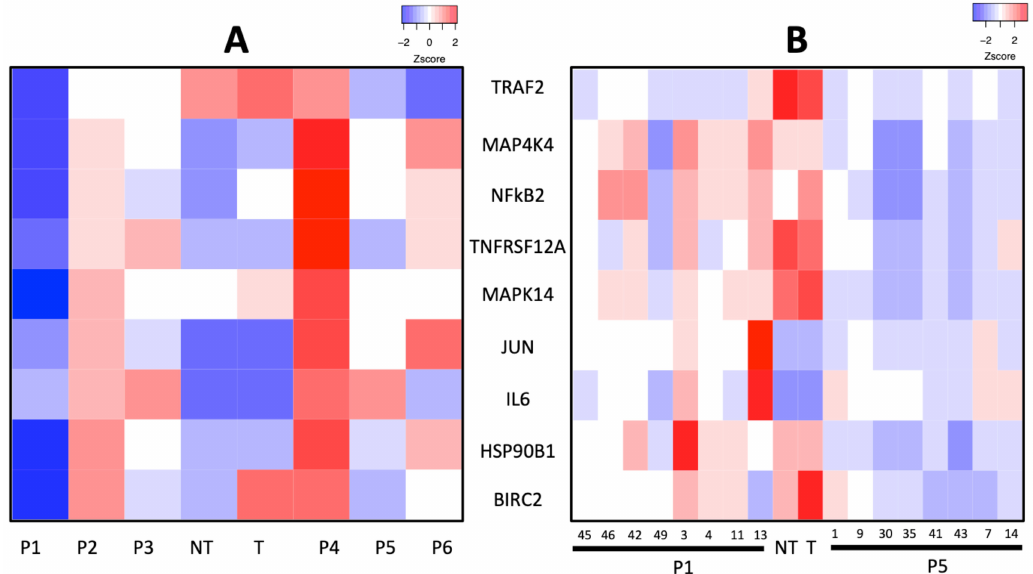
Figure 4. Gene expression of selected genes in TWEAK-Fn14 signalling pathway in response to peptide treatment. ( A ) Heatmap representing the normalized expression of genes (Y axis) in response to the treatment with pooled pep- tides (Pool 1 to 6; P1, P2, P3, P4, P5 and P6) as well as the response of BRV5 cells not treated (NT) and treated with TWEAK (T) (X axis). ( B ) Heatmap representing the normalized expression of genes (Y axis) in response to the treatment with individual peptides (P1 pool: P45, P48, P42, P49, P3, P4, P11, P13; P5 pool: P1, P9, P30, P35, P41, P43, P7, P14) as well as the response of BRV5 cells not treated (NT) and treated with TWEAK (T) (X